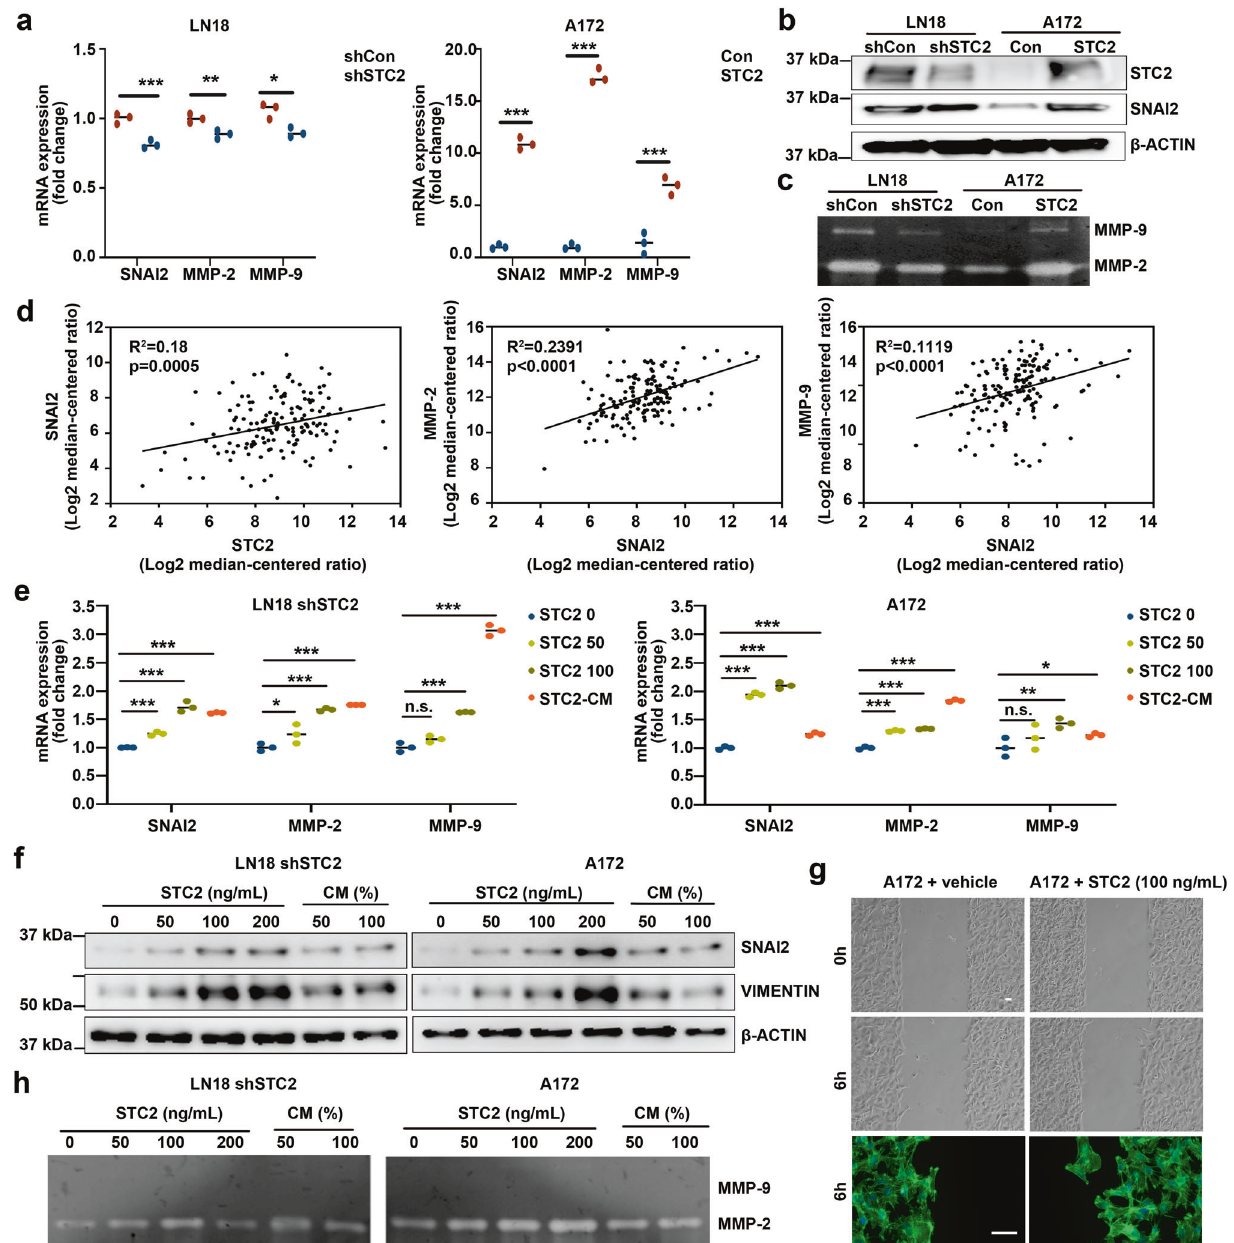
Fig. 4 STC2 targets SNAI2 and MMPs. a SNAI2 , MMP-2 , and MMP-9 mRNA expressions were validated after modulation of STC2 in LN18 or A172 cell lines. Means ± SD; n = 3 biological replicates; Student ’ s two tailed t-test, * p < 0.05, ** p < 0.01, *** p < 0.001. b SNAI2 protein expression was validated after modulation of STC2. c Proteolytic activities of MMP-2 and MMP-9 were determined by gelatin zymography after STC2 modulation. d The correlation of SNAI2 expression with STC2 (left), the correlation of MMP-2 expression with SNAI2 (middle), and the correlation of MMP-9 expression with SNAI2 (right) were determined in the TCGA data. e SNAI2 , MMP-2 , and MMP-9 mRNA expressions were measured after treatment of recombinant STC2 (50, 100 ng/mL) or STC2-containing CM (50%). Means ± SD; n = 3; One-way ANOVA, * p < 0.05, ** p < 0.01, *** p < 0.001, n.s., no signi fi cance. f SNAI2 protein expression was validated after treatment of recombinant STC2 (50, 100, 200 ng/mL) or STC2- containing CM (50, 100%). g In vitro migration was determined for 6 h after recombinant STC2 (100 ng/mL) treatment. Migrated cells were visualised by staining with fl uorescent phalloidin and DAPI. Scale bar = 50 µm. h Proteolytic activities of MMP-2 and MMP-9 were determined by gelatin zymography after recombinant STC2 (50, 100, 200 ng/mL) or STC2-containing CM (50, Since the identi fi cation of human STC2 cDNA, many structural normal tissues by analyzing tissue microarray and TCGA data. and molecular studies have demonstrated the function of STC2 Overexpression of intracellular STC2 or treatment with recombi- indirectly [15, 19, 31, 32]. However, its detailed regulatory nant STC2 increased GBM cell proliferation and invasive pheno- mechanisms are not fully understood. In renal cells, STC2 inhibits types. Our data suggest that STC2 has oncogenic potential that the promoter activity of type II sodium phosphate transporters, promotes GBM progression, thus making STC2 a potential target resulting in a reduction in phosphate uptake [19, 33]. STC2 has been for GBM treatment.